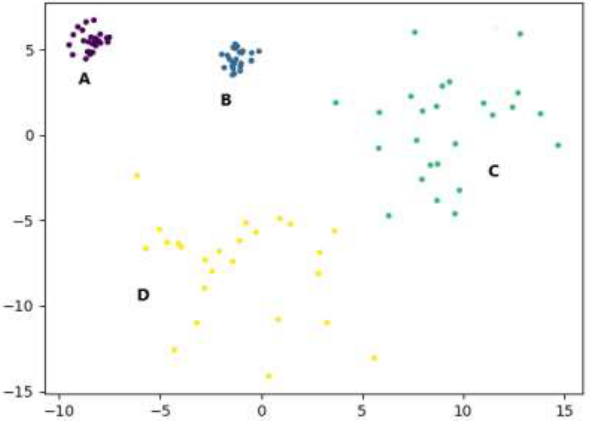
Figure 3. Scatter plots of artificially simulated datasets.